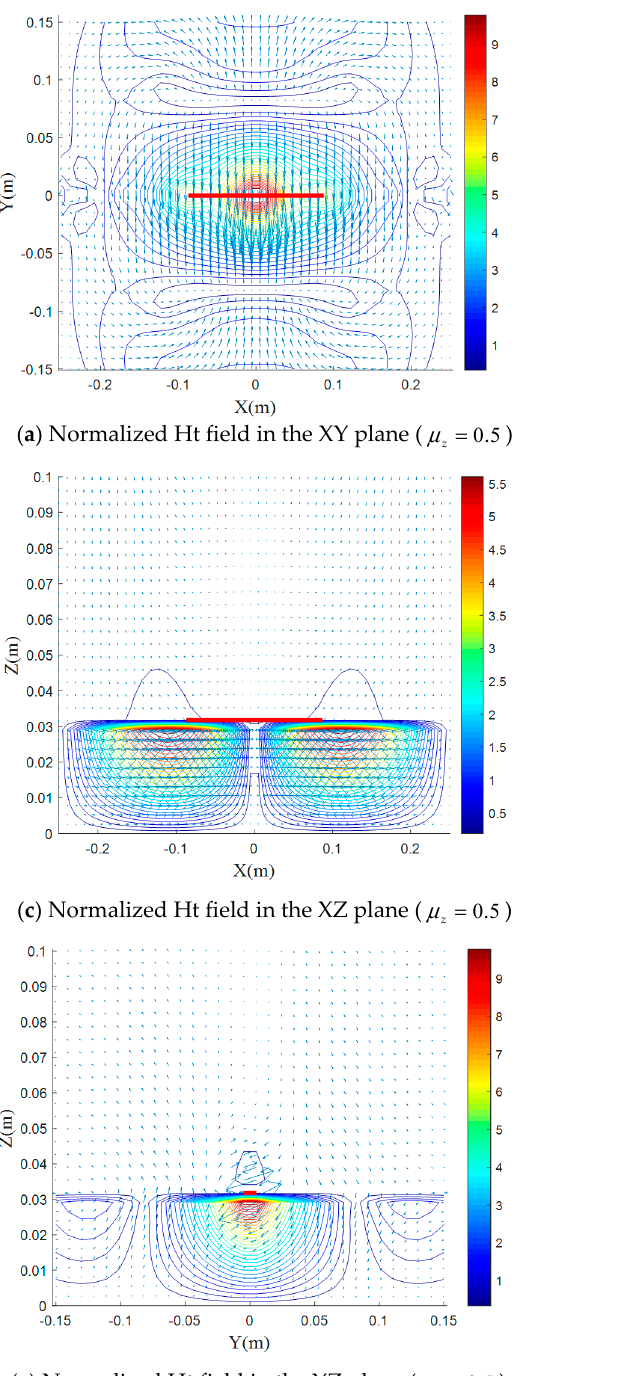
Figure 10. ( a – f ) Normalized magnetic field distributions for various values of µ z with ε z = ε t = 3.25 and µ t = 1, in the XY, XZ, and YZ plane.